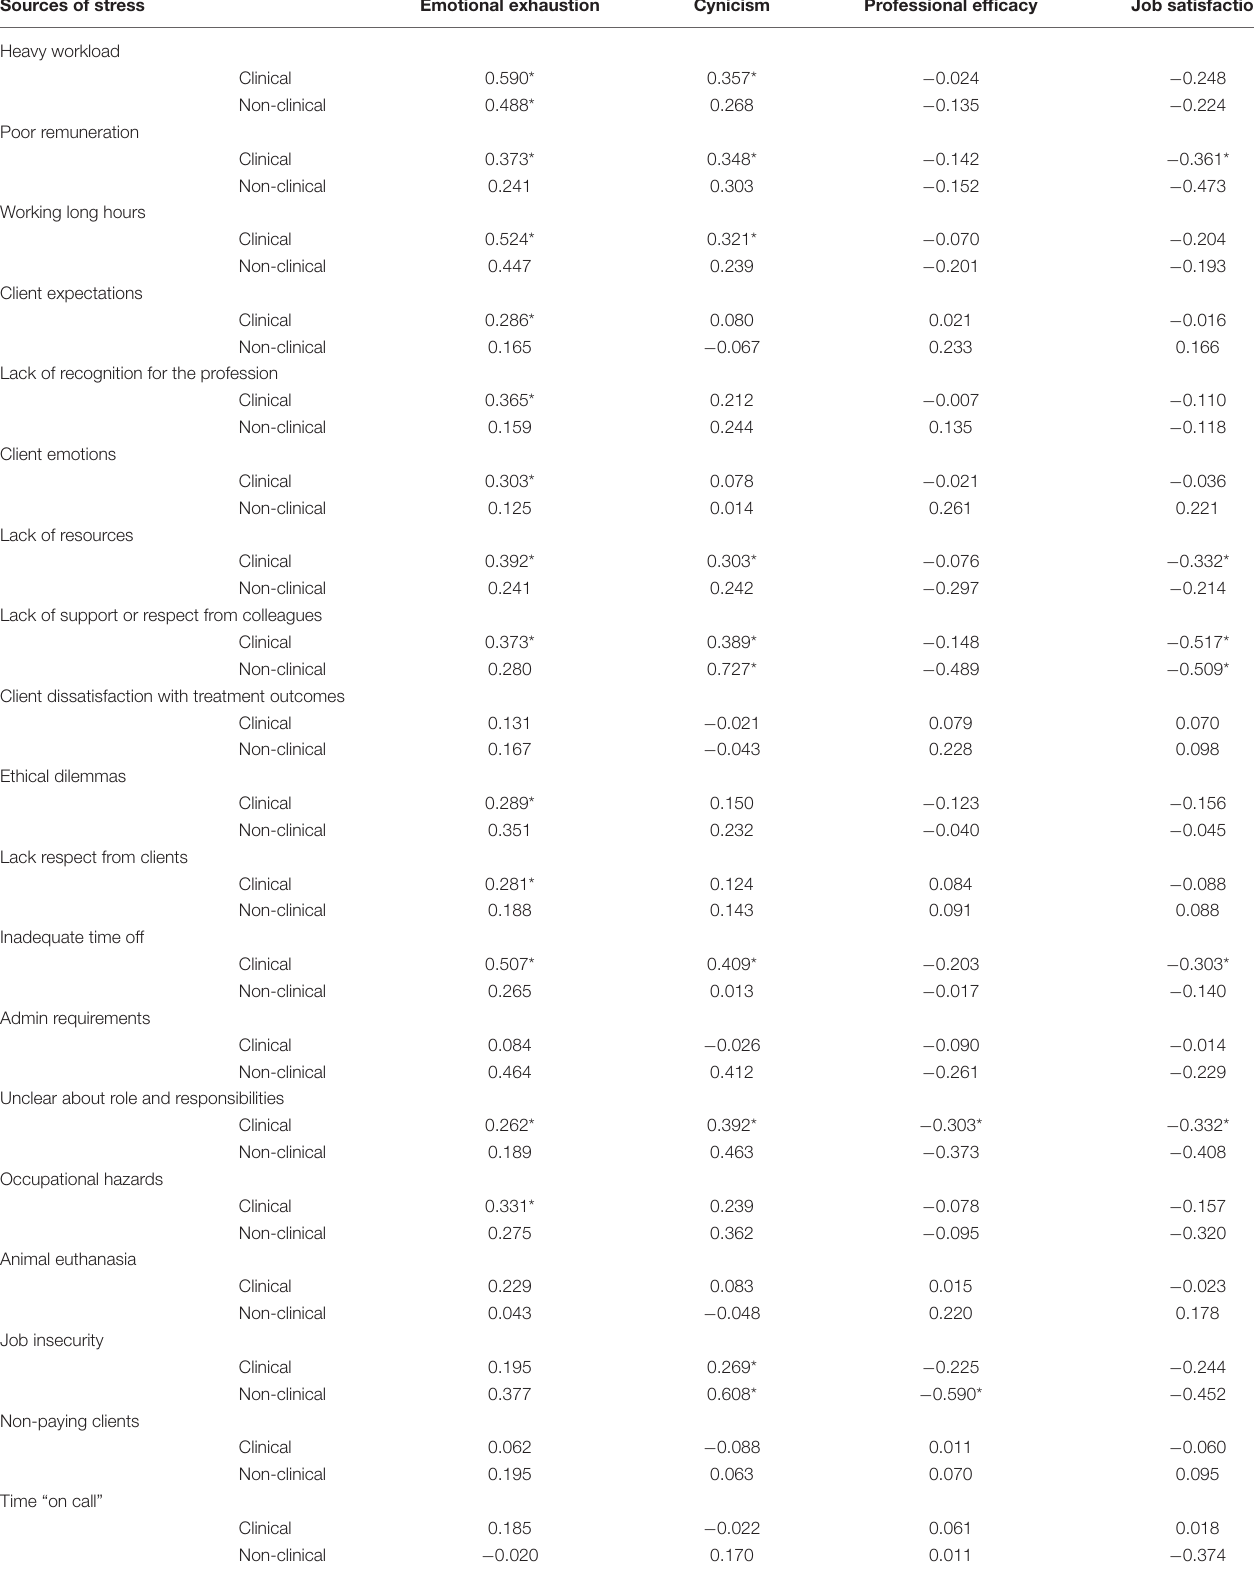
TABLE 5 | Correlations between sources of stress and symptoms of burnout and job